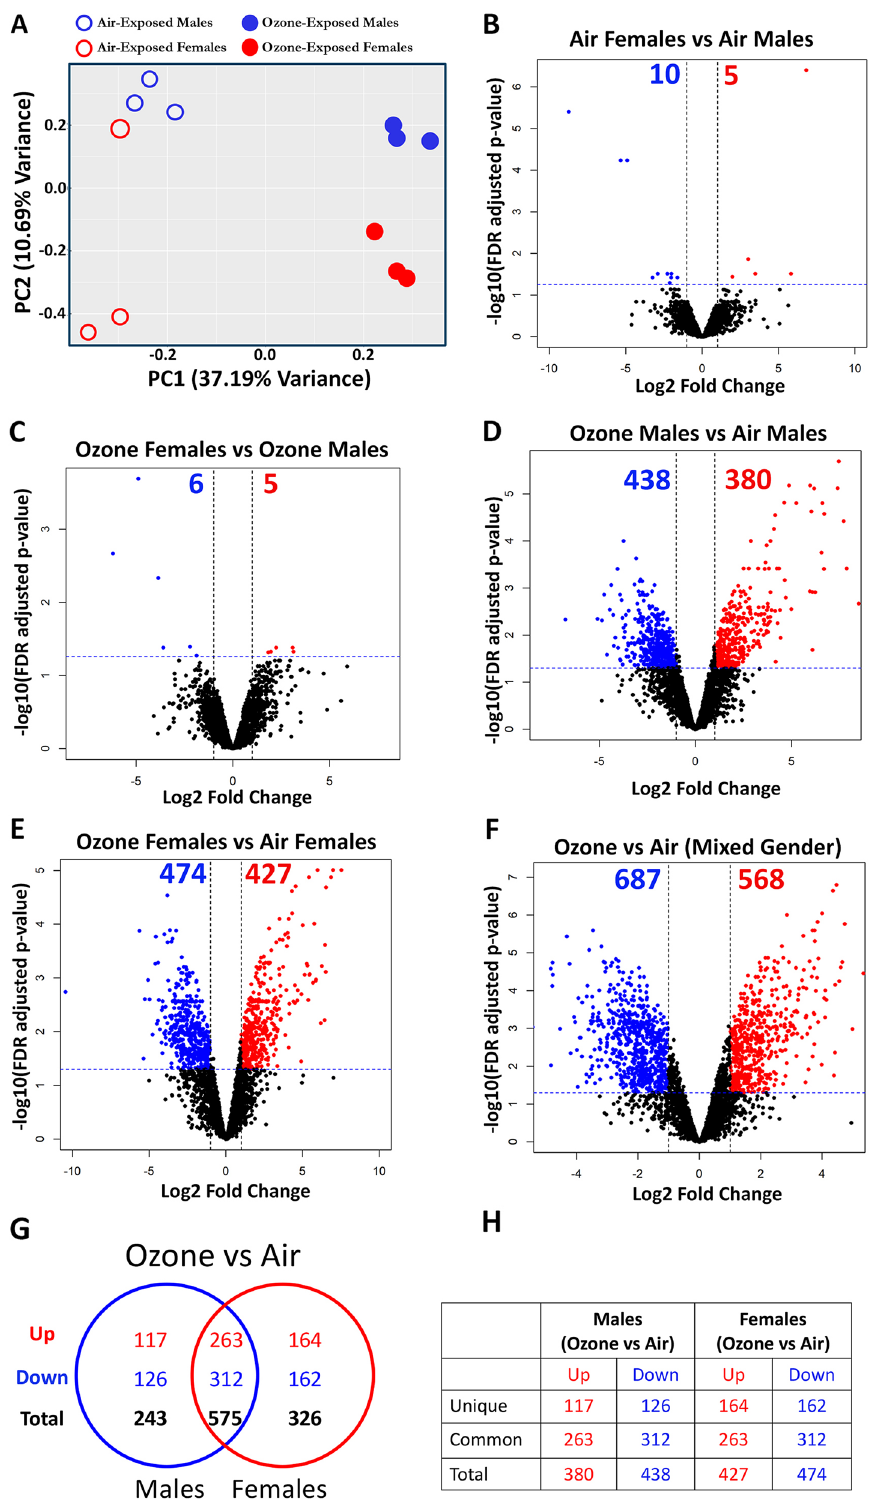
Figure 3. Ozone exposure results in alterations in the airspace exosome-bound proteome. ( A ) Two-dimensional principal component (PC) analysis plot using PC1 and PC2 on differentially enriched proteins (after normalization) in exosomes from the air- and ozone-exposed mice. ( B–F ) Volcano plots depicting differentially abundant proteins (enriched and low abundance) in four different comparisons that were identified using cutoff criteria [Log2 Fold change > 2, -Log10 (FDR adjusted p -values < 0.05)]. ( B ) air-exposed females versus air-exposed males, ( C ) ozone-exposed females versus ozone-exposed males, ( D ) ozone-exposed males versus air-exposed males, ( E ) ozone-exposed females versus air-exposed females. (n = 3 per sex per treatment) and ( F ) ozone-exposed mice (both sexes) versus air-exposed mice (both sexes). Venn diagram ( G ) depicting common and unique differentially enriched proteins (enriched and low abundance) in ozone-exposed males versus air-exposed males and ozone-exposed females versus air-exposed females. Tabular ( H ) summary of the Venn